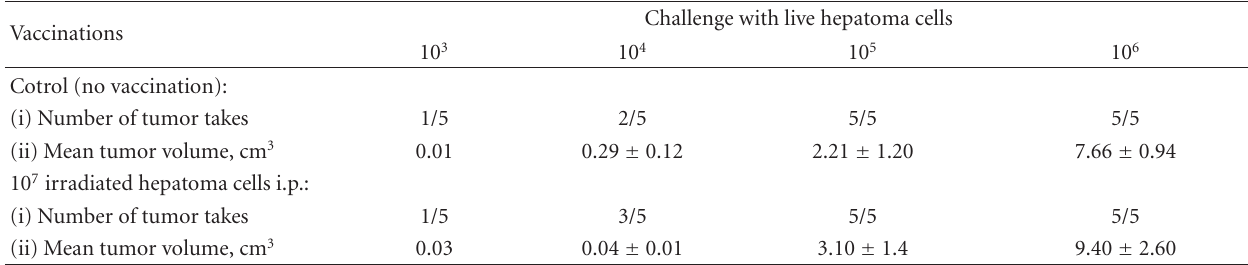
Table 1: Results of the transplantation